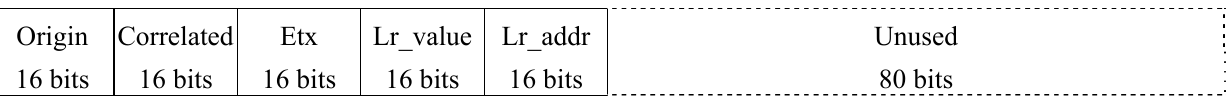
Figure 12. Correlation packet length (version 4).